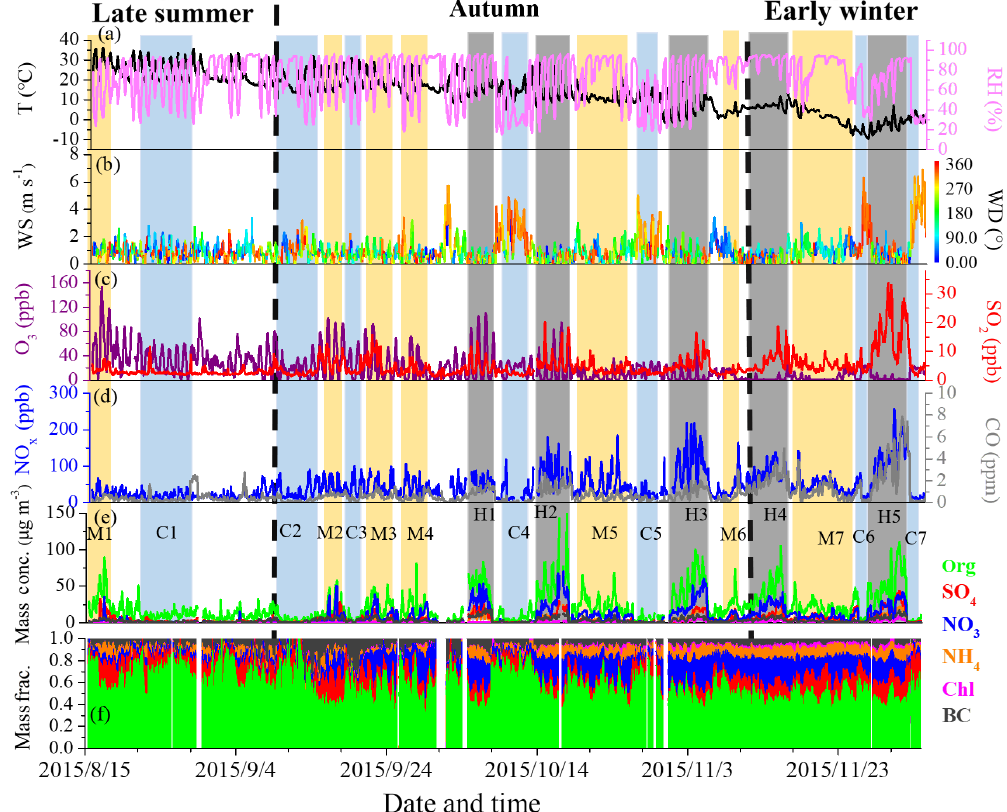
Figure 1. Time series of (a) temperature ( T ) and relative humidity (RH), (b) wind speed (WS) and wind direction (WD), (c) O 3 and SO 2 , (d) CO and NO x , (e) PM 1 species, and (f) mass fractions of PM 1 species during the entire study. Seven clean episodes (C1–C7), seven moderate-pollution episodes (M1–M7) and five high-pollution episodes (H1–H5) are marked for further discussion. The dates in this and other figures are given as